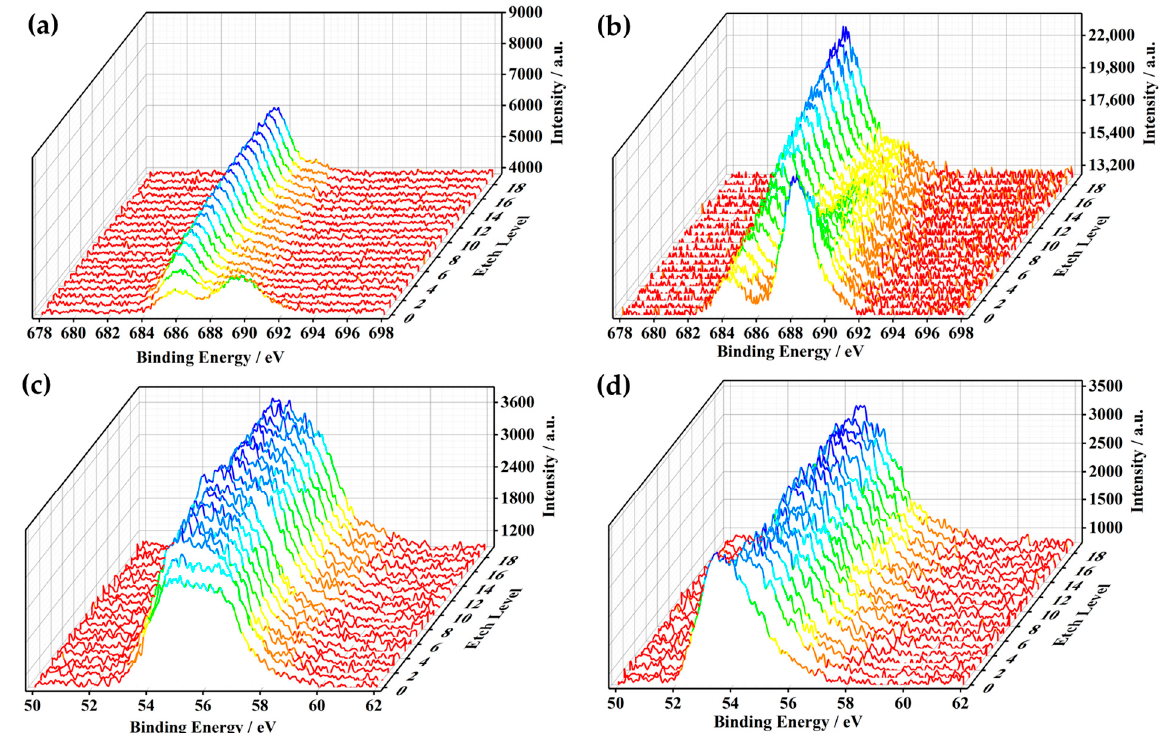
Figure 5. ( a , b ) XPS patterns (F1s) of lithium metal from Li/CPE/Li and Li/GCPE/Li after 700 h cycle. ( c , d ) XPS patterns (Li1s) of lithium metal from Li/CPE/Li and Li/GCPE/Li after 700 h cycle.